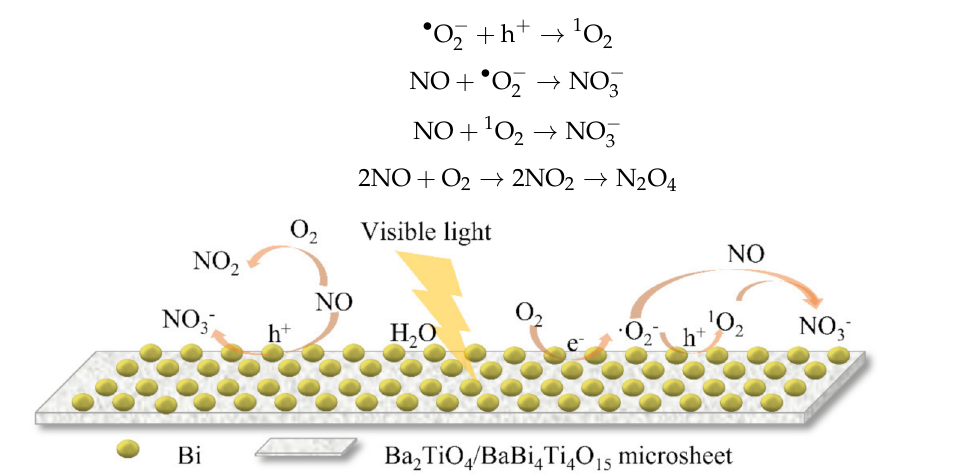
Figure 11. Possible reaction mechanism of photocatalytic NO removal over